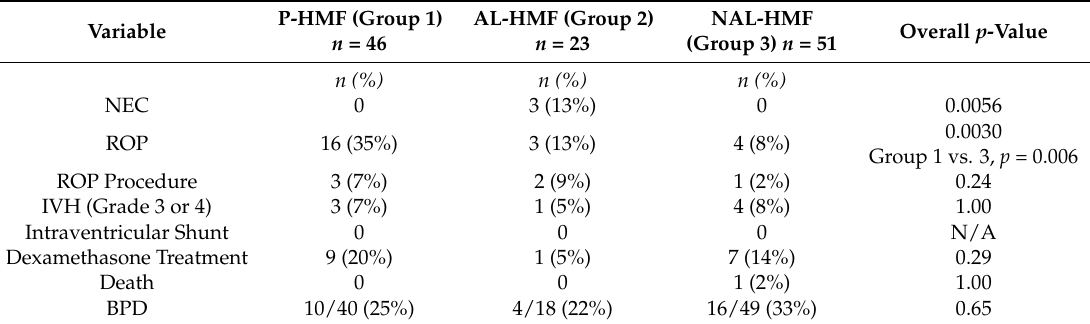
Table 3. Clinical outcomes of subjects by group.